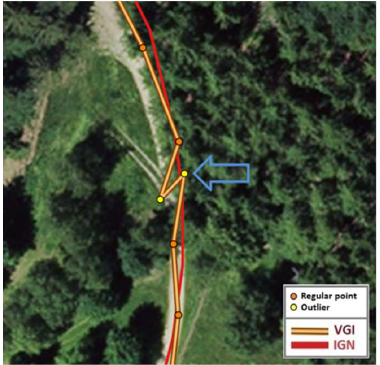
Figure 10. Illustration of a false positive outlier pointed out by the blue arrow.